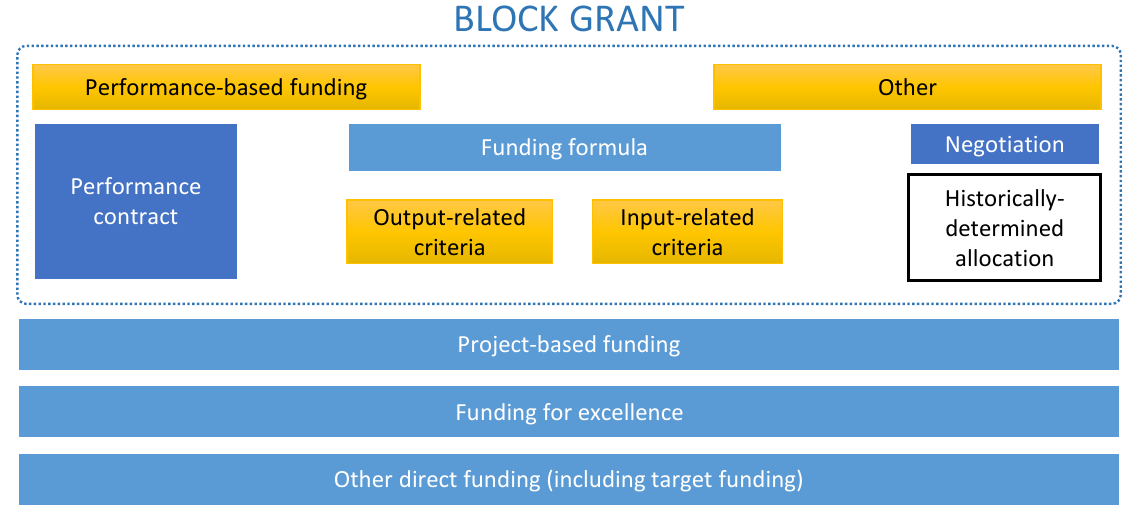
Figure 1. Variety of public funding allocation